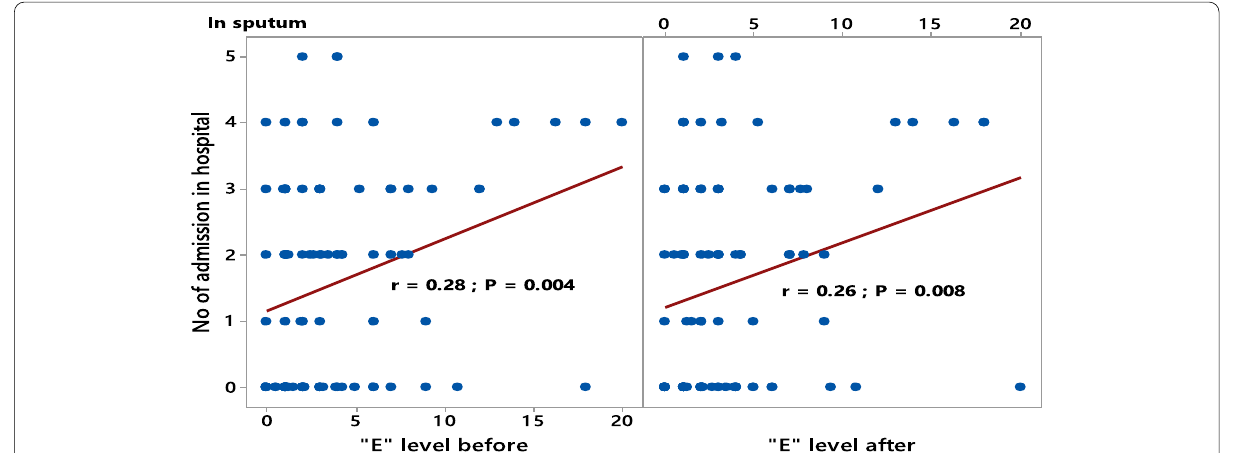
Fig. 2 Correlation between “E” levels in sputum with number of admissions in the last year